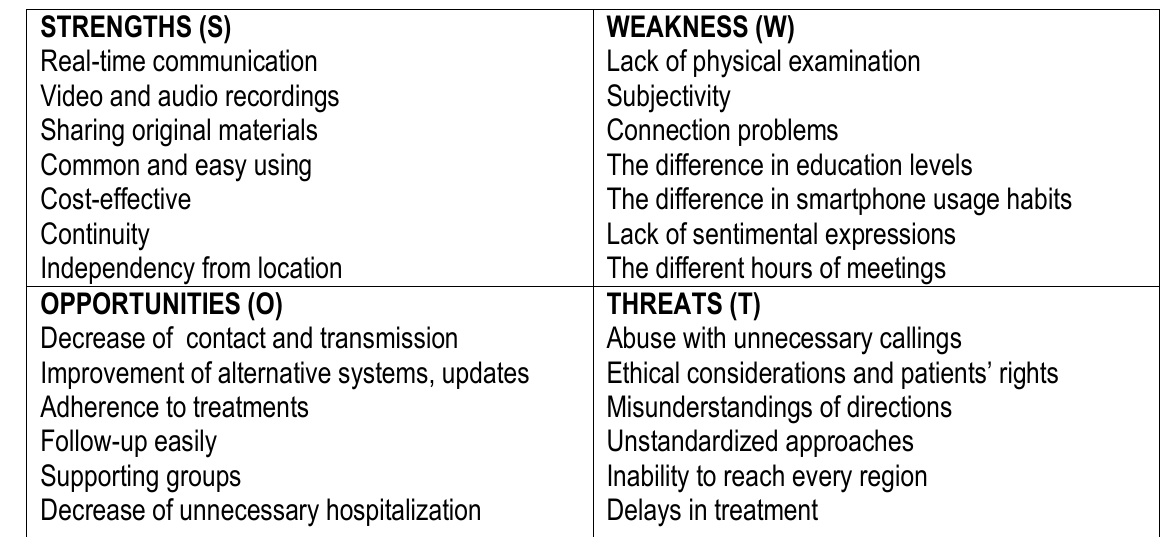
Table 1. The points with the contribution of literature